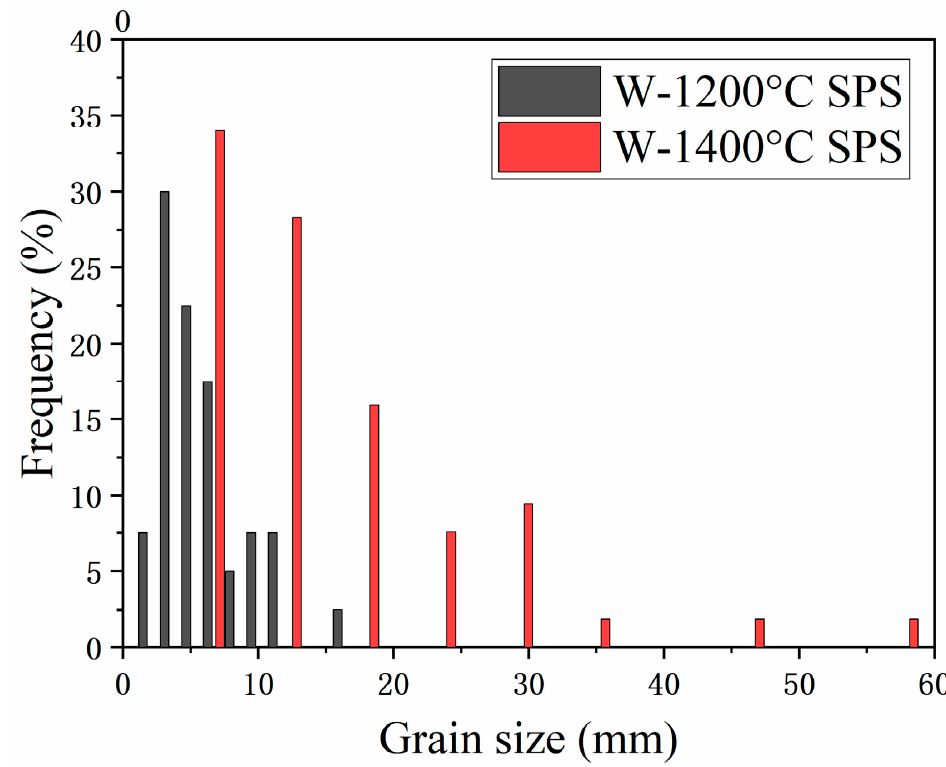
Figure 11. The size distribution of W grains in the W/Ta-laminated composite joined at 1200 °C.